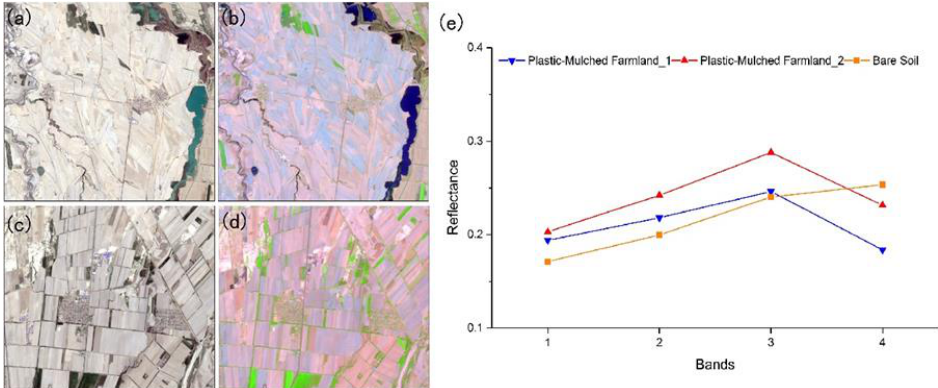
Figure 5. Two types of PMF as well as bare soil and the respective spectral reflectance curves. ( a , b ) The true color and arbitrary color composite (R = SWIR2, G = NIR, B = Blue) Sentinel-2 MSI image of PMF1 in the Shihezi City, Xinjiang, China; ( c , d ) the true color and arbitrary color composite (R = SWIR2, G = NIR, B = Blue) Sentinel-2 MSI image of PMF2 in Shihezi City, Xinjiang, China; and ( e ) the spectral reflectance curves of bare soil, PMF1 and PMF2 by Sentinel-2 MSI imagery (1: Blue; 2: Red; 3: NIR; 4: SWIR2).